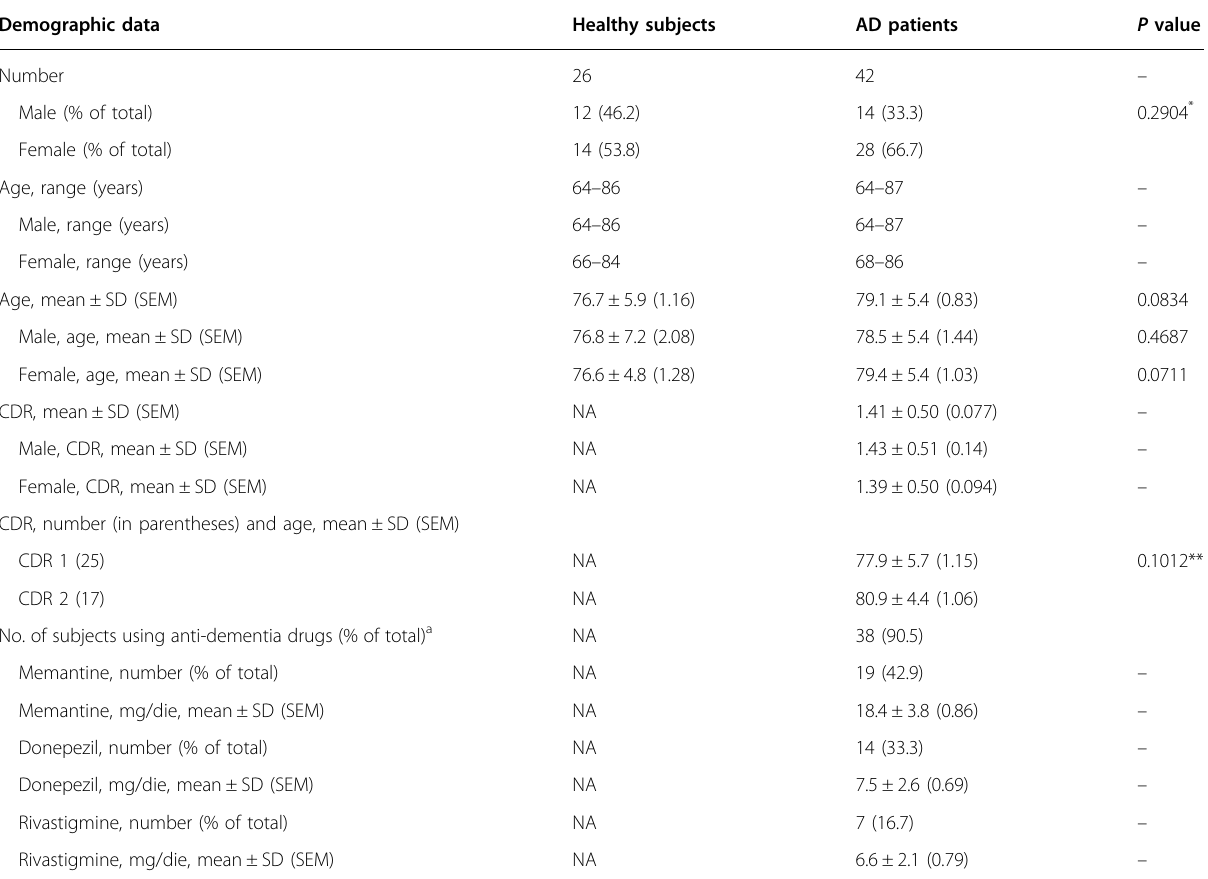
Table 1 Demographic and clinical data of the subjects enrolled for the study. Demographic